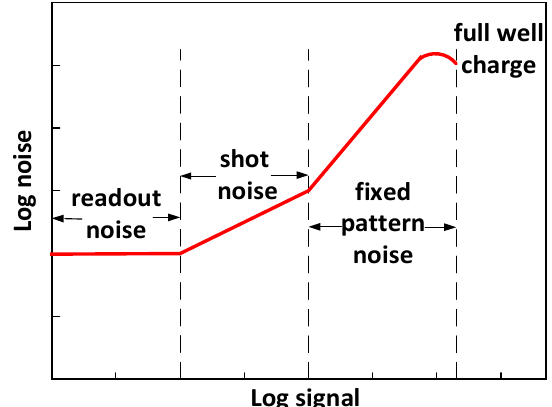
Figure 4. Noise signal transfer curve illustrating three noise regions over the dynamic range.